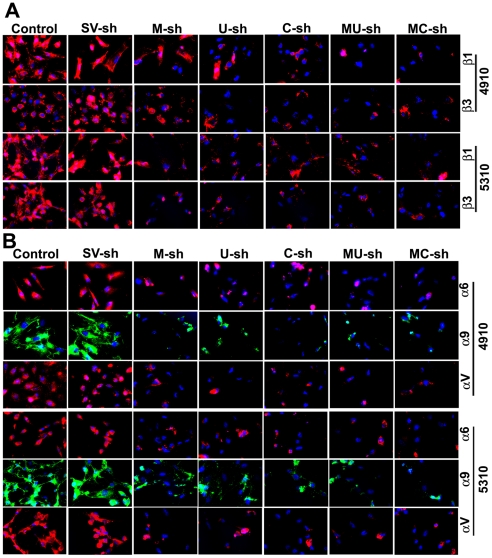
Effect of shRNA plasmid constructs on the expression of integrins at protein level.(A) Immunocytochemistry was performed to evaluate the effect of various shRNA treatments on the expressions of β1 and β3 integrins. Microscopic images demonstrate β1 and β3 integrin expressions (red fluorescence) in 4910 and 5310 cells transfected with scrambled vector (SV-sh), MMP-9 (M-sh), uPAR (U-sh), cathepsin B (C-sh), MMP-9/uPAR (MU-sh) and MMP-9/cathepsin B (MC-sh). All treatments reduced β1 and β3 integrins expression. (B) The effect of various shRNA treatments on the expressions of α6, α9 and αV integrins was also evaluated and the microscopic images demonstrate α6, α9 and αV integrins expression in 4910 and 5310 cells transfected with SV-sh, M-sh, U-sh, C-sh, MU-sh and MC-sh. All the treatments reduced α6, α9 and αV integrins expression in both the cell lines.